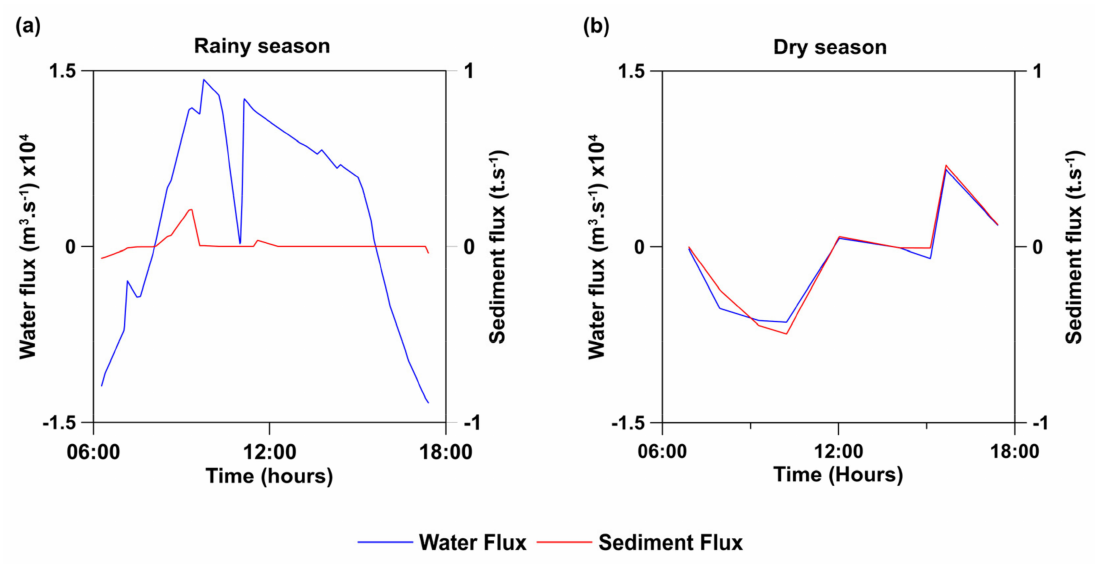
Figure 6. Water (blue line) and sediment (red line) fluxes for the Gurupi estuary during the rainy season ( a ) and dry season ( b